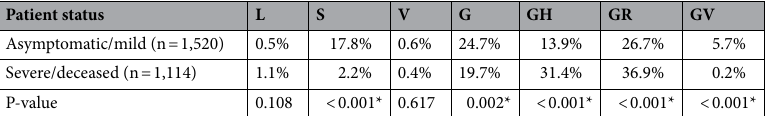
CFRs (P-value = 0.020). Higher medians of the number of coexisting clades were shown in the group of countries where above median cases, deaths and CFRs were recorded. The impact of the distribution of individual clades on the disease epidemiology was also analyzed. Distribu- tion bias of some clades was noted, as shown in Table 1. This was statistically significant for all clades with all disease epidemiology parameters. Among all studied cases, patient’s clinical status were specified for only 2,634. Based on the provided data, such cases were grouped into asymptomatic/mild cases and severe/deceased cases. Although clades GH, and GR were significantly more prevalent among viral genomes isolated from severe/deceased cases, L clade showed the same distribution but with P-value > 0.05. In contrast all other clades showed higher prevalence in asymptomatic/ mild cases than severe/deceased ones. This was statistically significant for all clades except clade V (Table 2). Analysis based on the chronological distribution of SARS-CoV-2 clades was done for 404,496 cases for which the exact date of collection was available. The analysis showed that clade L predominated at the beginning of the pandemic. Thereafter, new clades evolved including the clades S and V. Viral clades carrying D614G mutation also emerged. Of them, clade G first emerged and soon split into the clades GH and GR. A gradual regression of all clades was then noted with an expansion of clade GR that predominated the scene for six months till the emergence of the last clade, “GV”, by which it was rapidly outweighed. Currently, GV clade is distributed in at least 49 countries predominantly in the United Kingdom (73.3% of the reported GV cases). The global chrono- logical distribution of SARS-CoV-2 clades is shown in Fig. 2. The origins and the evolution time of SARS-CoV-2 clades inferred from the genomes submitted to GISAID are shown in Table 3. Gender distribution of SARS‑CoV‑2 clades. Analysis of 96,350 cases (Males = 49,454, Females = 46,896) for which patient gender was specified showed gender distribution bias for some clades (Table 4). This was statis- tically significantly for clades L and G that showed higher prevalence in males than females. Similarly, the clades GR and GV were more frequently isolated from females than males with P-value less than 0.05. The severity of cases in both genders were compared in 2495 cases for which both gender and patient’s clini- cal status are known. Among the group of cases for which the clinical status was recorded as severe or deceased, the number of male patients was significantly higher than female patients (49.9% versus 35.4%, P-value < 0.001). Clinical status of patients infected by SARS-CoV-2 of different clades in different gender groups is shown in Fig. 3. Age distribution of SARS‑CoV‑2 clades. The distribution of the genomes that belonged to different clades in different age groups was analyzed among 95,848 cases for which the patient age was specified (Table 5). As shown in Table 5, viral isolates belonging to clade GR were more common in adult patients than other groups. Meanwhile, children were the age group from which the clades GH and GV were more frequently isolated. Isolation of all other clades was commonest in elderly patients compared to others. Clinical status of patients of different age groups from which viral genomes belonging to different clades were isolated is shown in Fig. 4. A significant correlation was found between age groups and patient’s clinical status. The analysis included 2,524 cases for which both patient age and clinical status are known (Fig. 4). Severe/deceased cases were sig- nificantly more prevalent in elderly than in adults (71.9% vs 31.6%, Pearson Chi-Square P-value < 0.001) or in